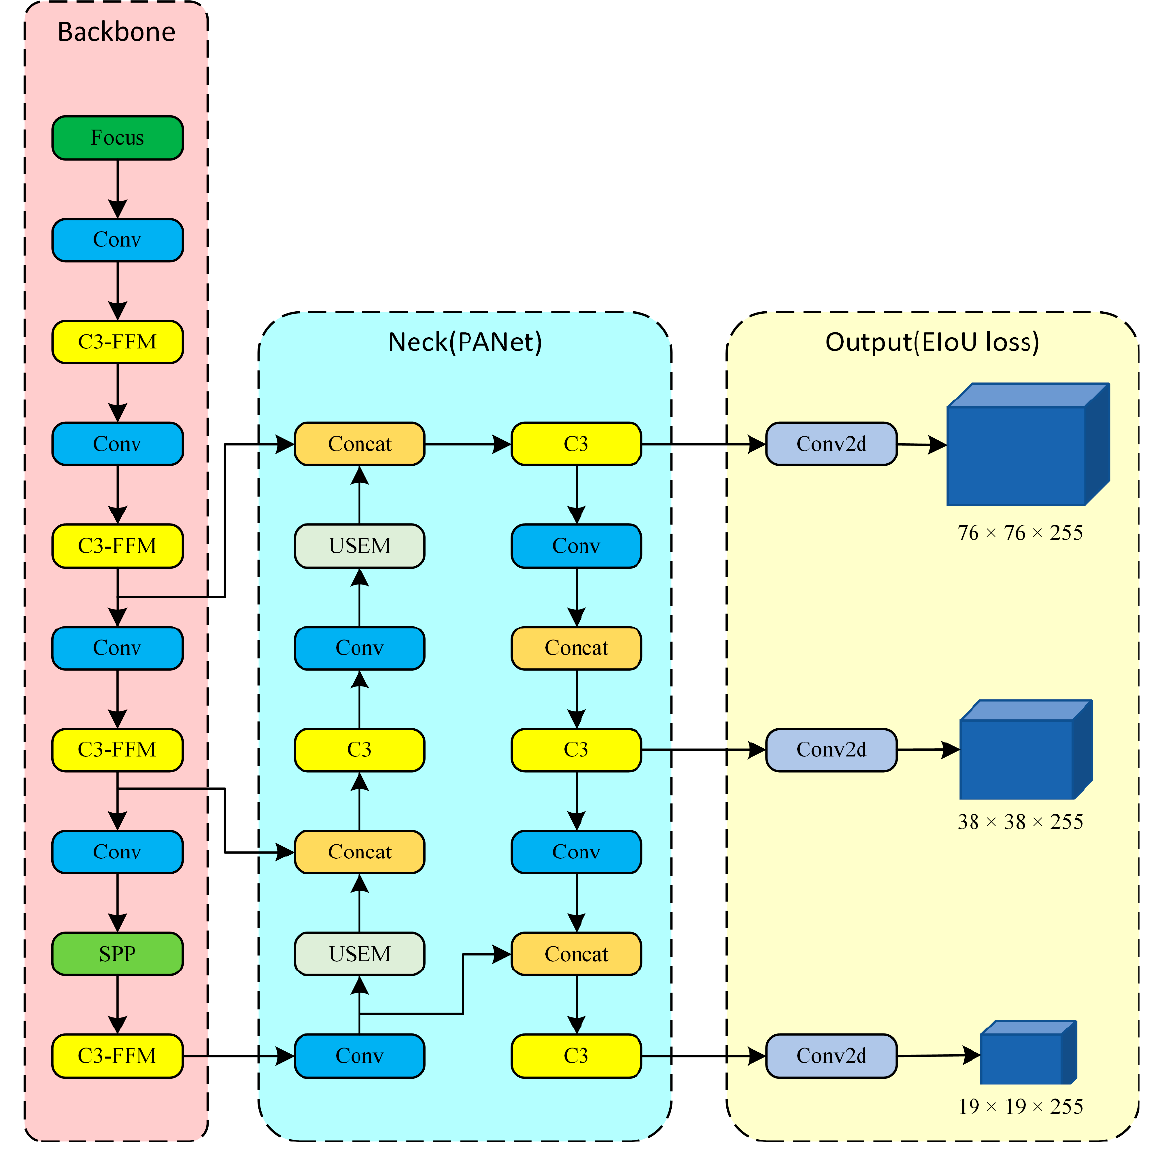
Figure 5. ME ‐ YOLO network structure. Figure 5. ME-YOLO network